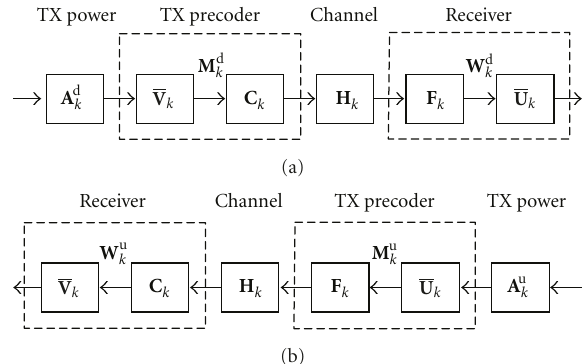
Figure 1: Ideal signal processing chain for multiuser zero forcing: (a) downlink, (b)